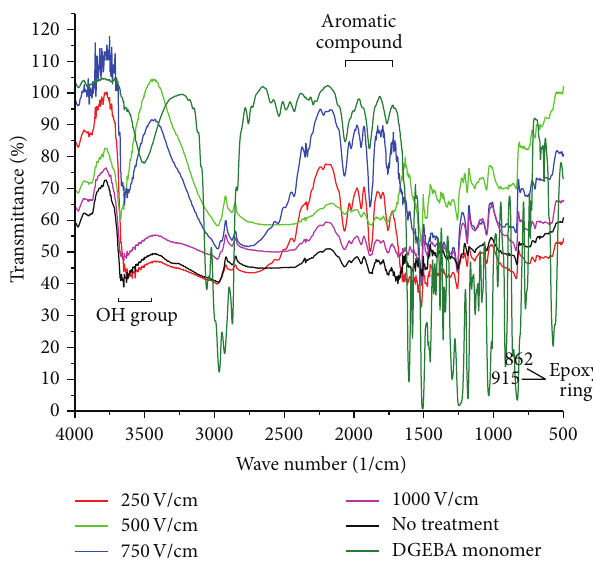
Figure 5: FTIR spectra of epoxy cured in AC electric fields.